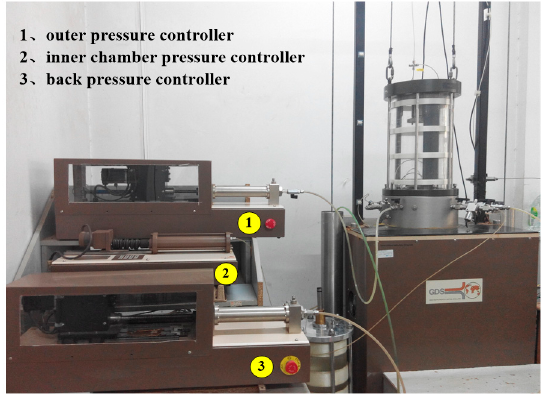
Figure 2. GDS hollow cylinder apparatus test system .